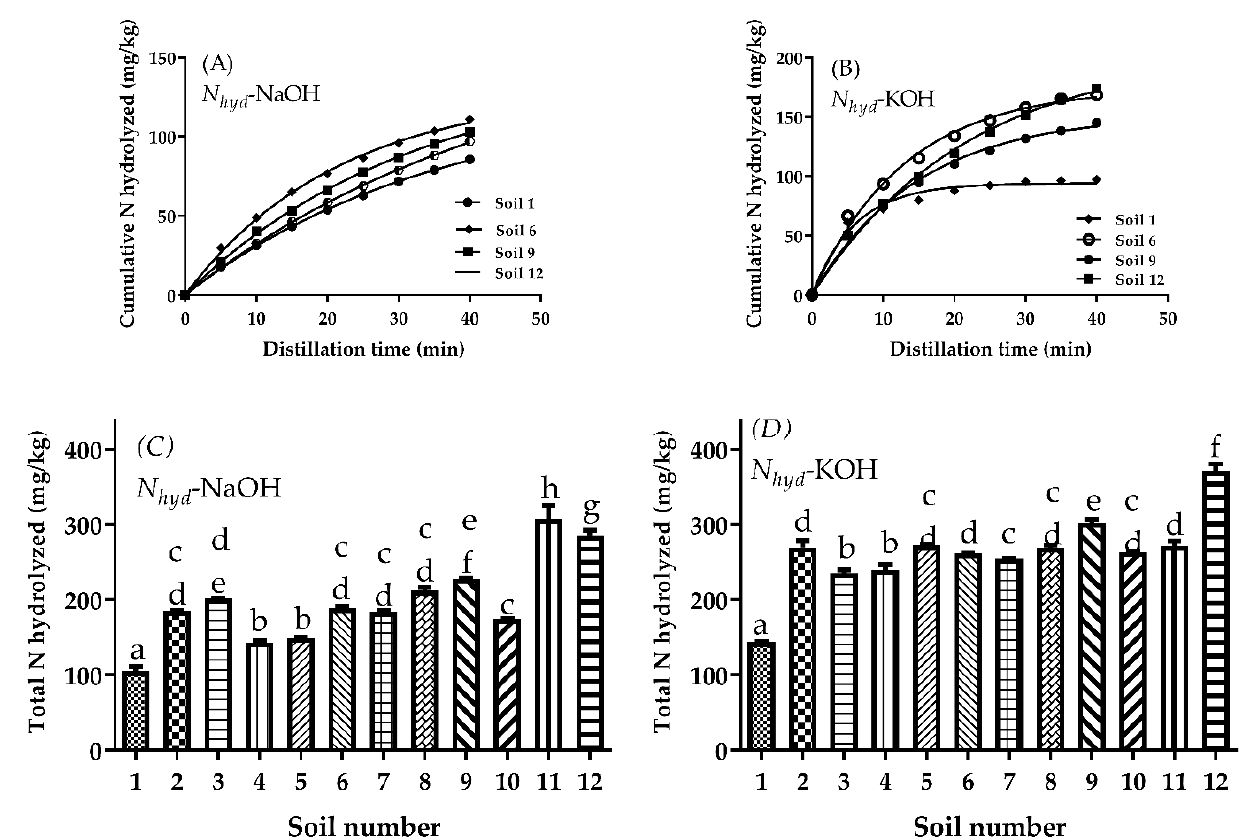
Figure 2. Cumulative N hydrolyzed with time of distillation using 1 M NaOH ( A ) and 1 M KOH ( B ) in four of the soils used. Total N hydrolyzed from the soils using 1 M NaOH ( C ), and 1 M KOH ( D ). Error bars represent standard error of three replicates. Within each reagent, bars followed by the same letter are not significantly different at p = 0.05.